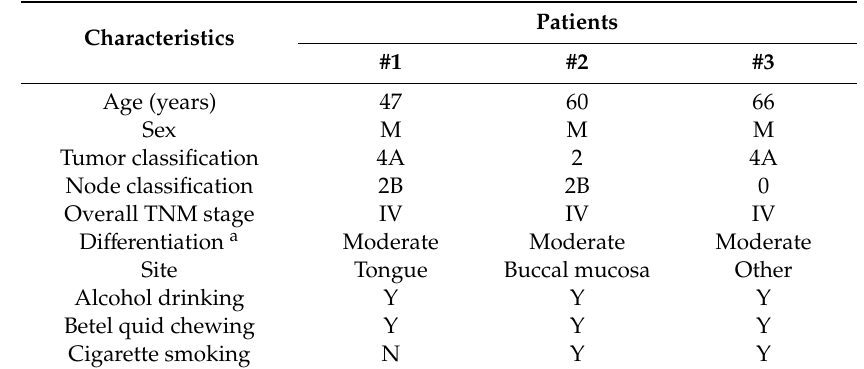
Table 1. Characteristics of the oral cavity squamous cell carcinoma (OSCC) patients enrolled for the patient-derived xenograft (PDX) model